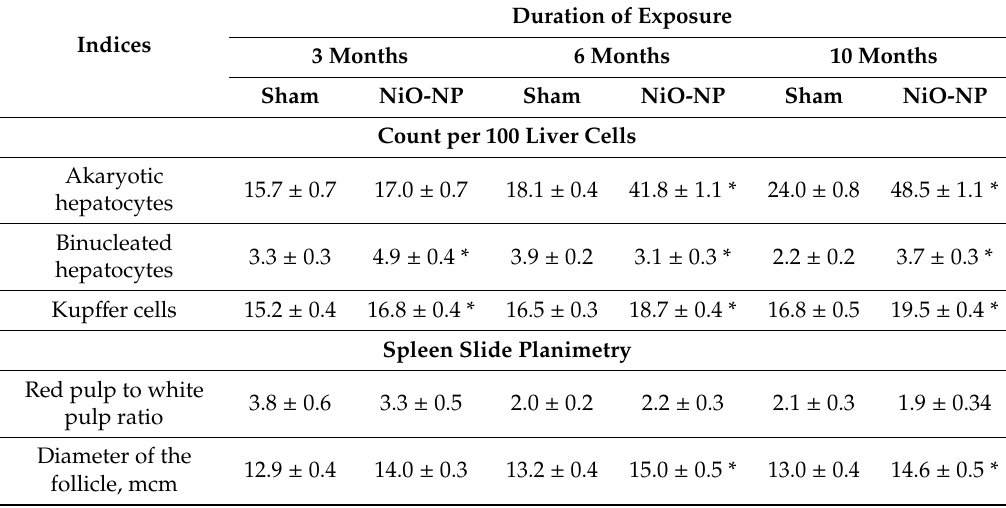
Table 7. Morphometric indices for the state of rat’s liver and spleen after inhalation exposure to NiO-NPs at a 0.23 ± 0.01 mg / m 3 concentration for 3, 6, or 10 months; mean results for at least 3 rats in exposed